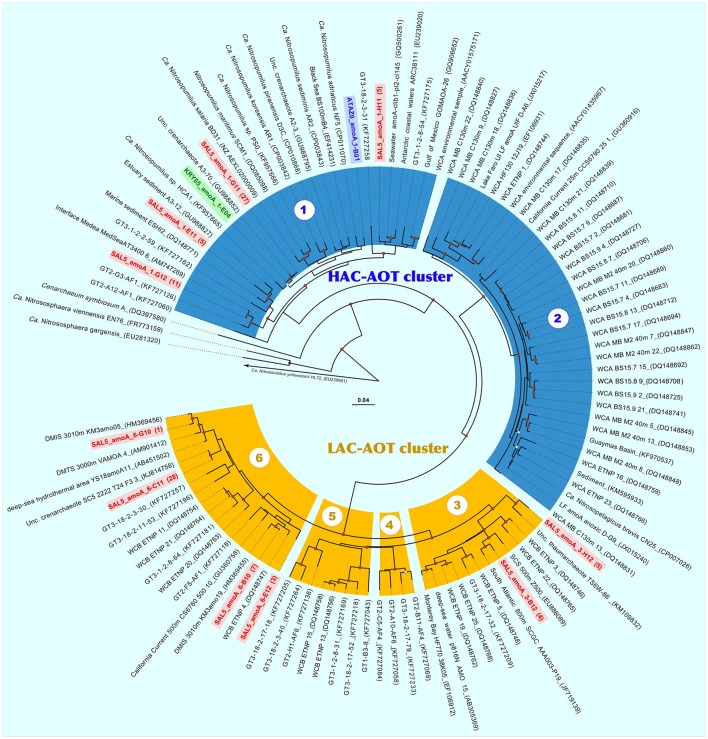
Neighbor-joining phylogenetic nucleotide tree of thaumarchaeotal amoA obtained from the three stably nitrifying enrichments ATA, KRY, and SAL5. The marine clades 1–2 of high ammonia concentration ammonium-oxidizing archaea (HAC-AOT) and the marine clades 3–6 of low ammonia concentration ammonium-oxidizing archaea (LAC-AOT), as defined by Sintes et al. (2016), are color-coded as aquamarine and yellow, respectively. Sequences of enrichments are also color-coded according to types of clone library origins, as blue (ATA), green (KRY), and red (SAL5). Significant bootstrap values are shown as open (>50) and red-filled (>70) circles at branch nodes.